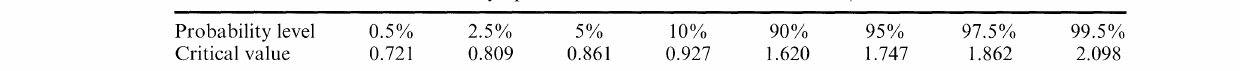
Asymptotic critical values of the modified R/S statistic Probability